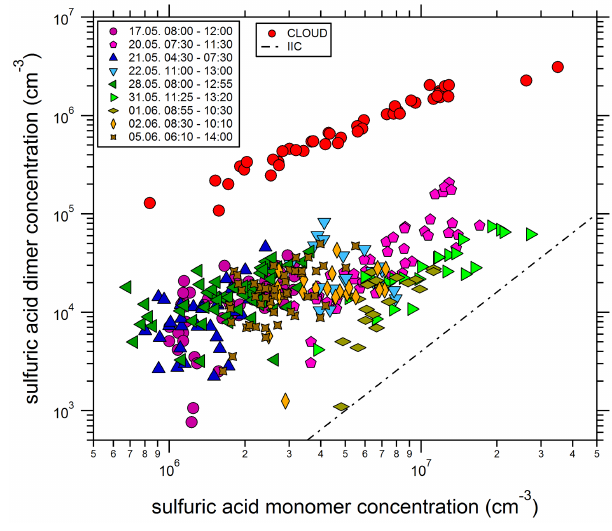
Figure 6. Sulfuric acid dimer concentrations as a function of the sulfuric acid monomer concentrations. The legend on the left lists the periods when high dimer signals were observed. In addition, data from CLOUD chamber experiments with at least 10pptv of dimethylamine are shown; under these conditions dimer formation proceeds at or close to the kinetic limit (Kürten et al., 2014). The dashed-dotted line indicates the lower detection limit for neutral dimers set by ion-induced clustering (IIC) within the CI-APi-TOF ion reaction